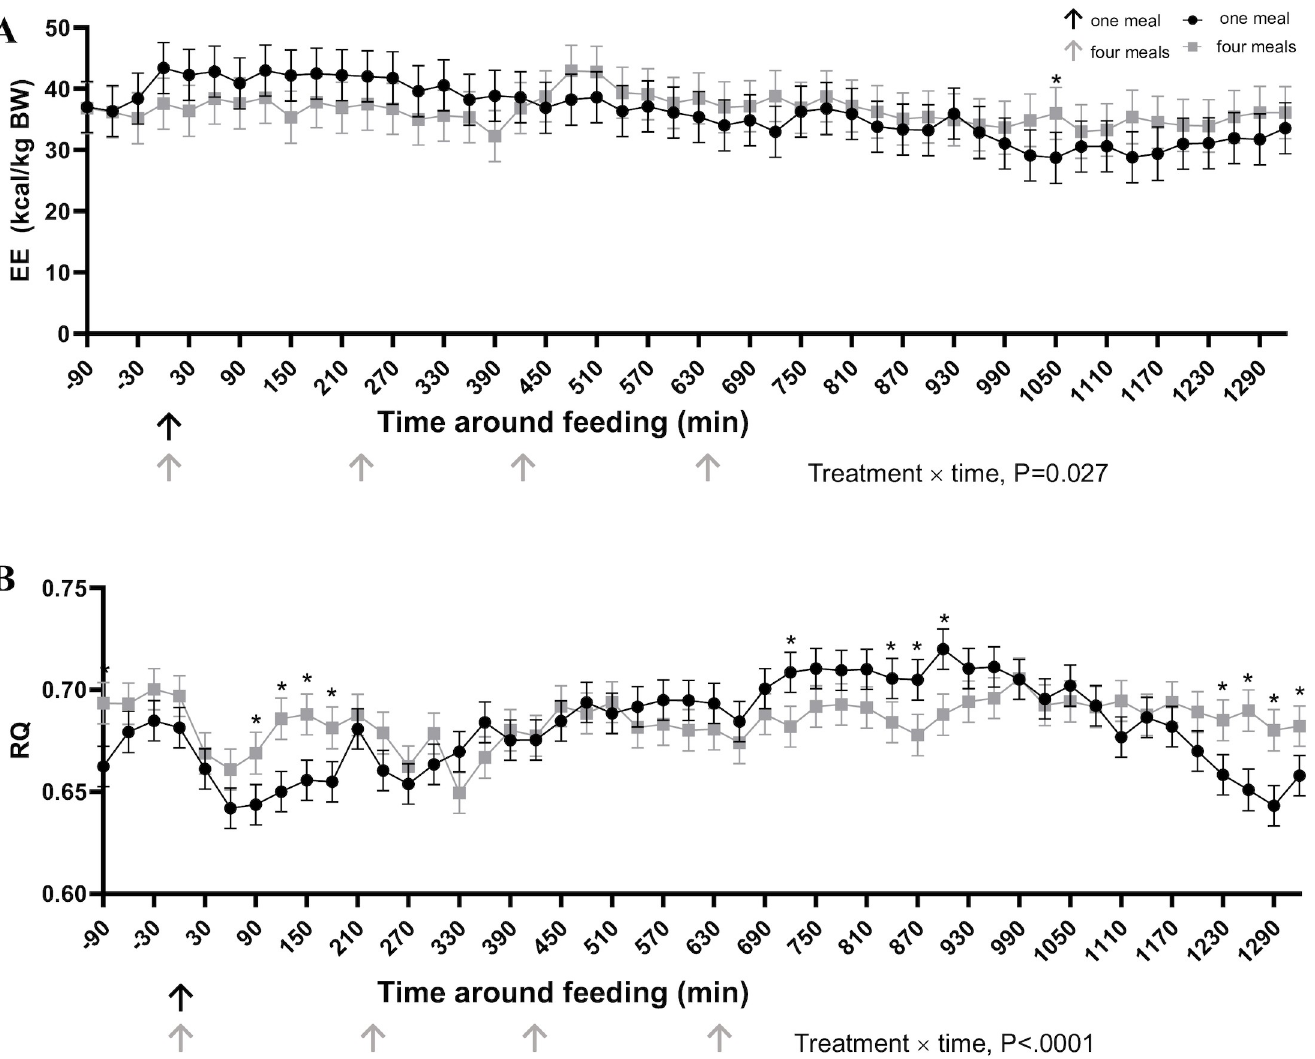
Fig 6. Energy expenditure (EE) (kcal/kg BW) (A) and respiratory quotient (RQ) (B) in cats eating a canned diet once (0800h) or four (0800h, 1130h, 1500h, and 1830h) times daily over 24 hours (n = 8 but with 12 experimental periods). Values are expressed as LSM ± SEM. � = P <